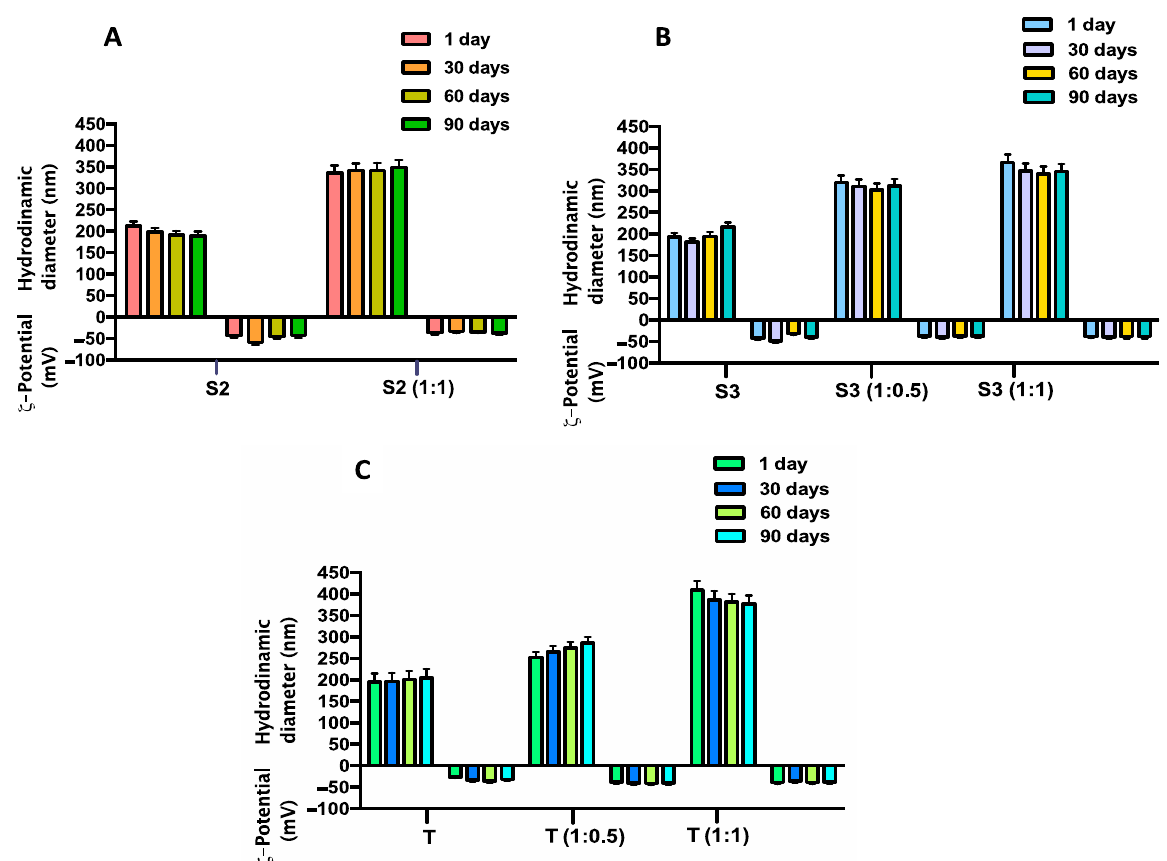
Figure 5. Time stability studies in terms of hydrodynamic diameter and ζ -potential variations of uncoated and of HA-Chol-coated niosomes up to 90 days at 25 °C temperature of storage. Panel A: sample S2, uncoated and coated (S2 1:1) ; Panel B: sample S3, uncoated and coated (S3 1:0.5; S3 1:1); Panel C: sample T, uncoated and coated (T 1:1). Biological stability of HA-Chol-coated vesicles was determined in presence of bo- vine serum evaluating the hydrodynamic diameter and ζ -potential variations up to 3 h at